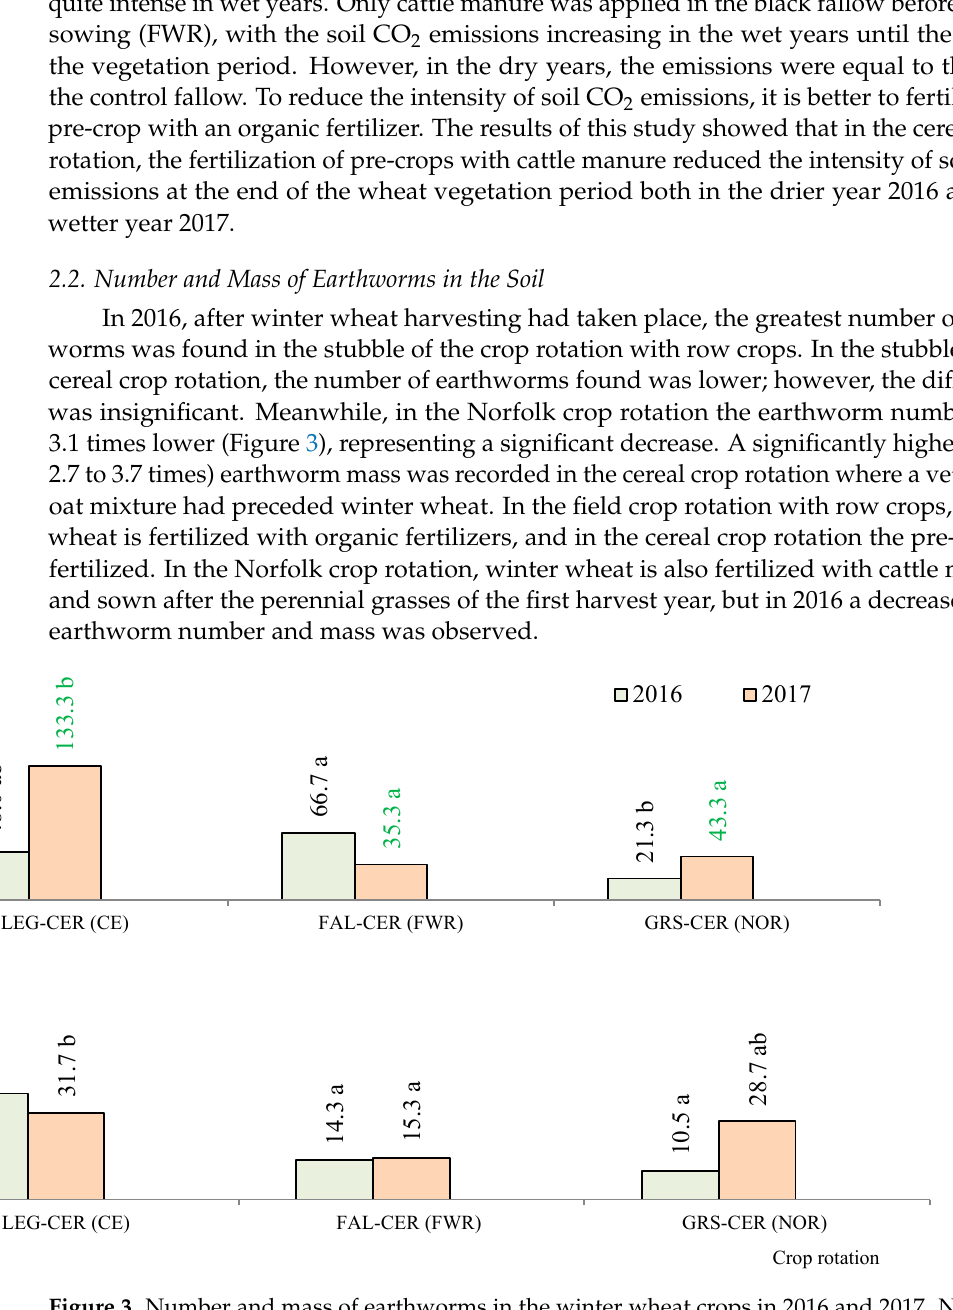
Figure 3. Number and mass of earthworms in the winter wheat crops in 2016 and 2017. Note: a,b indicate significant differences between the treatments ( p ≤ 0.05). FAL-CONTROL, continuous bare fallow; LEG-CER (CE), winter wheat pre-crop was a vetch and oat mixture for green forage while the crop rotation was cereal; FAL-CER (FWR), winter wheat pre-crop was black fallow while the crop rotation was field with row crops; GRS-CER (NOR), winter wheat pre-crop was a clover–timothy mixture while the crop rotation was